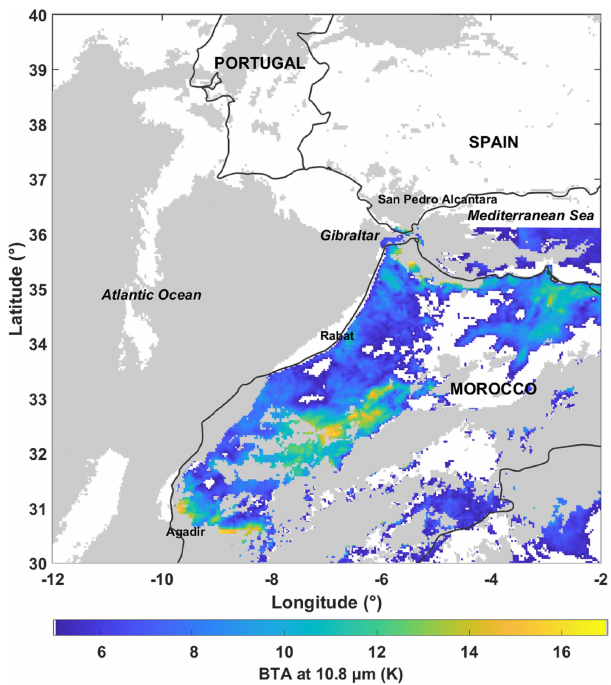
Figure 14. Brightness temperature anomaly (BTA) on 11 August 2011 at 12:00UTC. The cloud mask has been applied in